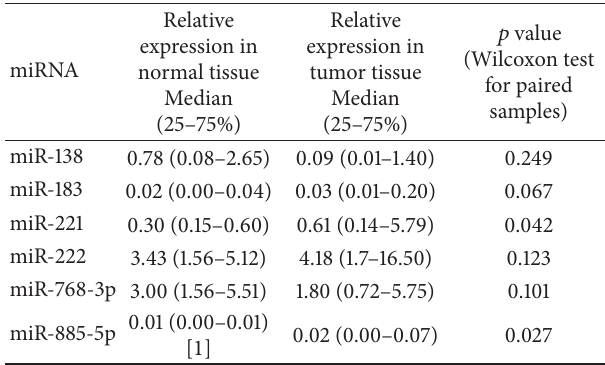
Table 3: Relative expression of miRNAs in normal and tumor samples of patients without metastases.